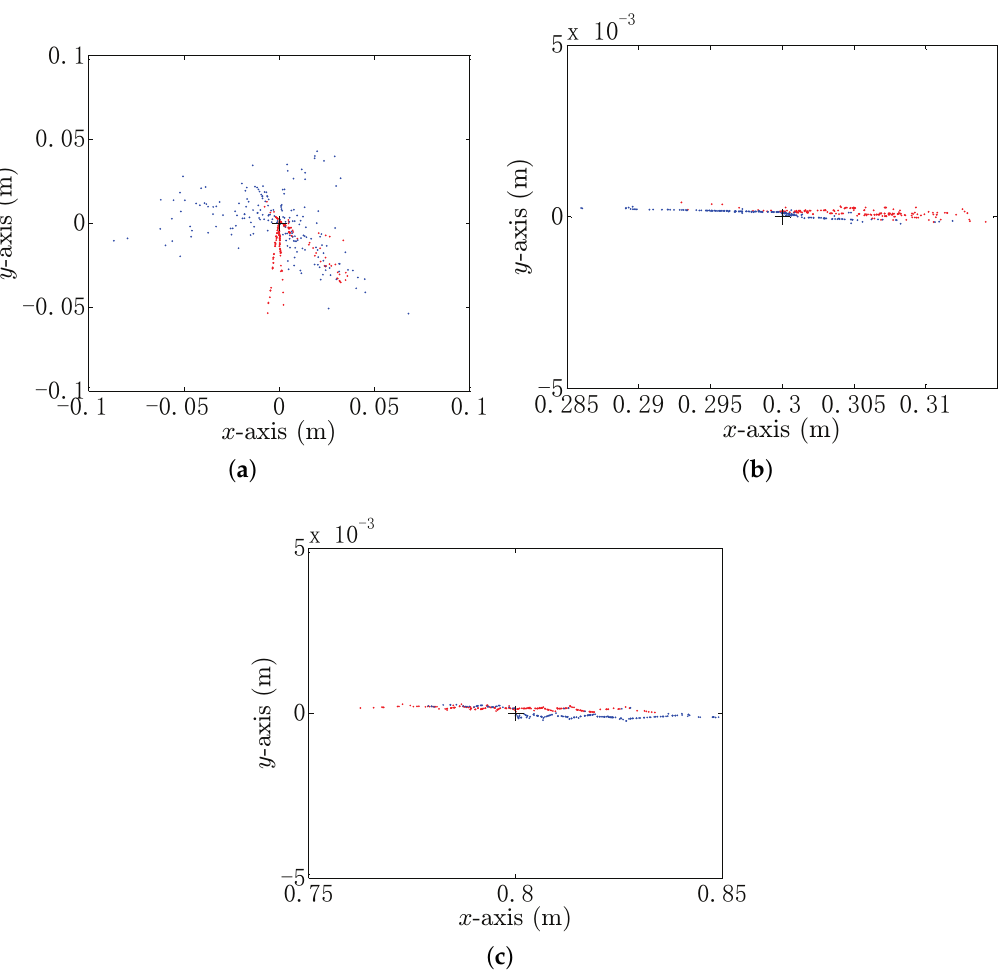
Figure 7. The 200-times independent locating operation by using the BEM model and the simplified model with SNR = 20 dB. The black cross indicates the real position of the target. ( a ) The estimated position of the conductor target whose true localization is ( 0,0,0.1 ) m; ( b ) the estimated position of the conductor target whose true localization is ( 0.3,0, 0.1 ) m; ( c ) the estimated position of the conductor target whose true localization is ( 0.8,0,0.1 )